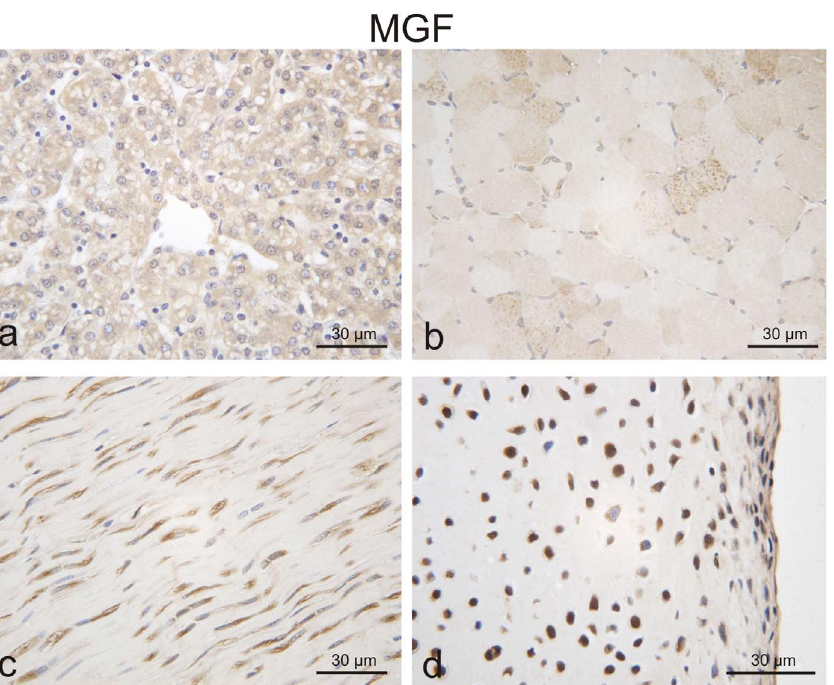
Figure 6. Immunohistochemical detection of MGF in porcine liver (a) tendon (c) and articular cartilage (d). Only weak staining was seen in porcine skeletal muscle (b), (magnification 40 6 ).